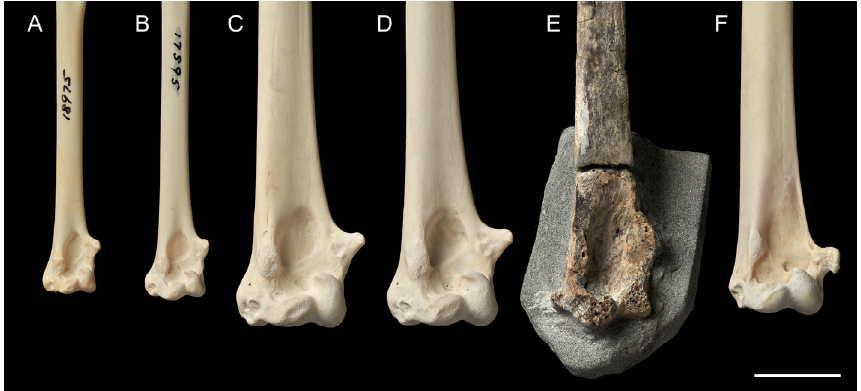
Figure 4. Detail of proximal end of the left humeri of selected Procellariiformes in cranial view; scale bar = 2 cm. ( A ) Antarctic petrel Thalassoica antarctica (Gmelin, 1789), NMNZ OR.018975. ( B ) Antarctic fulmar Fulmarus glacialoides (Smith, 1840), NMNZ OR.017595. ( C ) Macronectes giganteus , NMNZ OR.029141. ( D ) Macronectes halli , NMNZ OR.029173. ( E ) Macronectes tinae sp. nov., paratype NMNZ S.048870. ( F ) Indian yellow-nosed albatross Thalasarche carteri (Rothschild, 1903), NMNZ OR.028477.